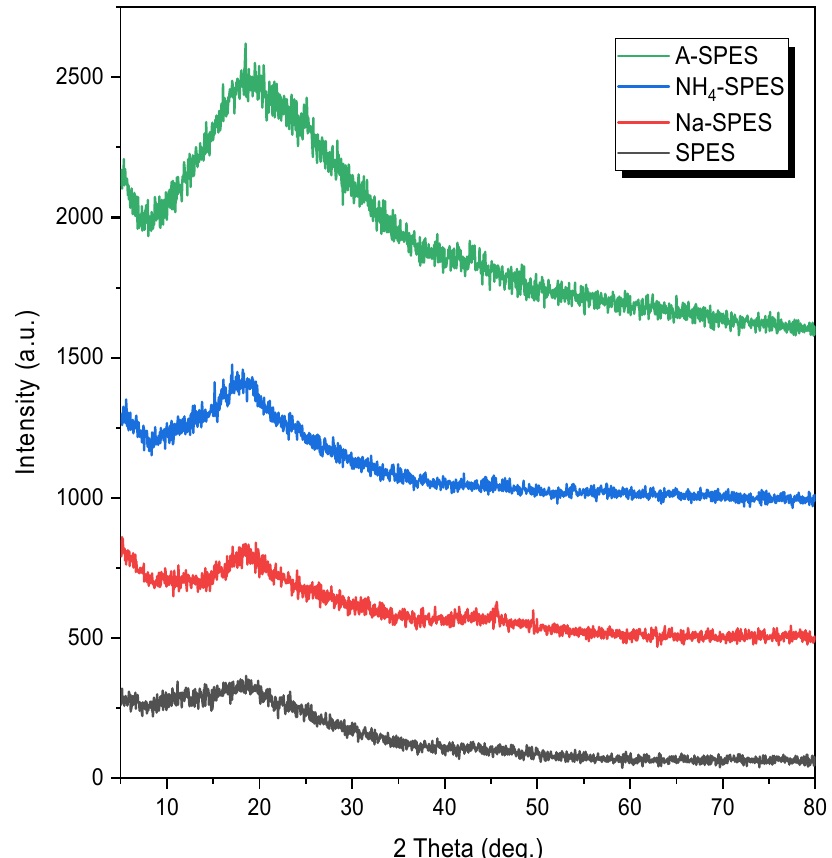
Figure 4. X-ray diffraction patterns of the modified PES materials.